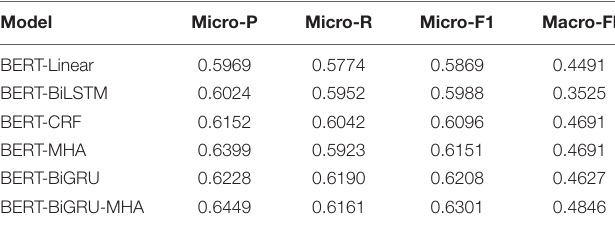
TABLE 5 | Comparison between the experimental results of models based on the service